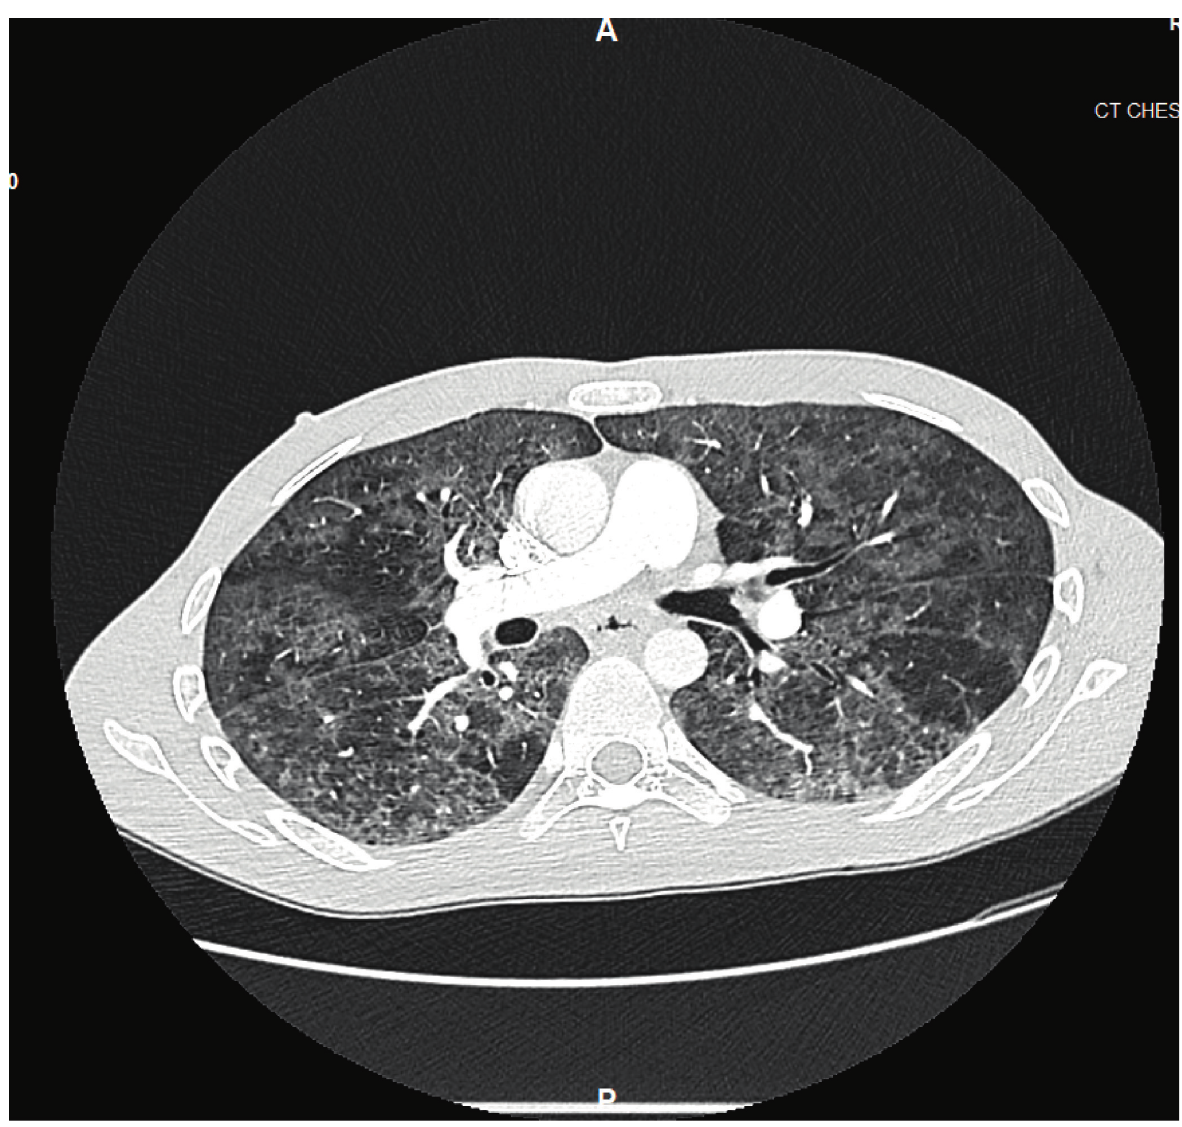
Figure 2: Chest CT showing diffuse bilateral ground glass